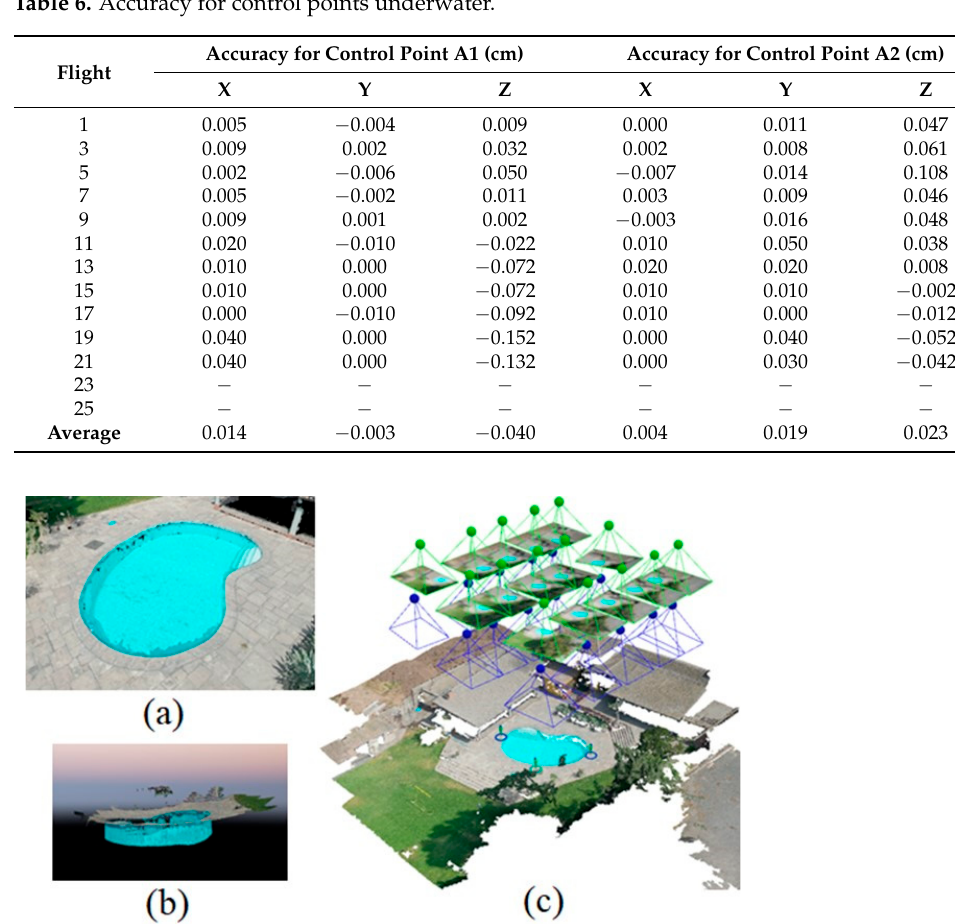
Figure 7. Pool image processing: ( a ) top view of the point cloud; ( b ) side view of the point cloud; ( c ) image processing view.